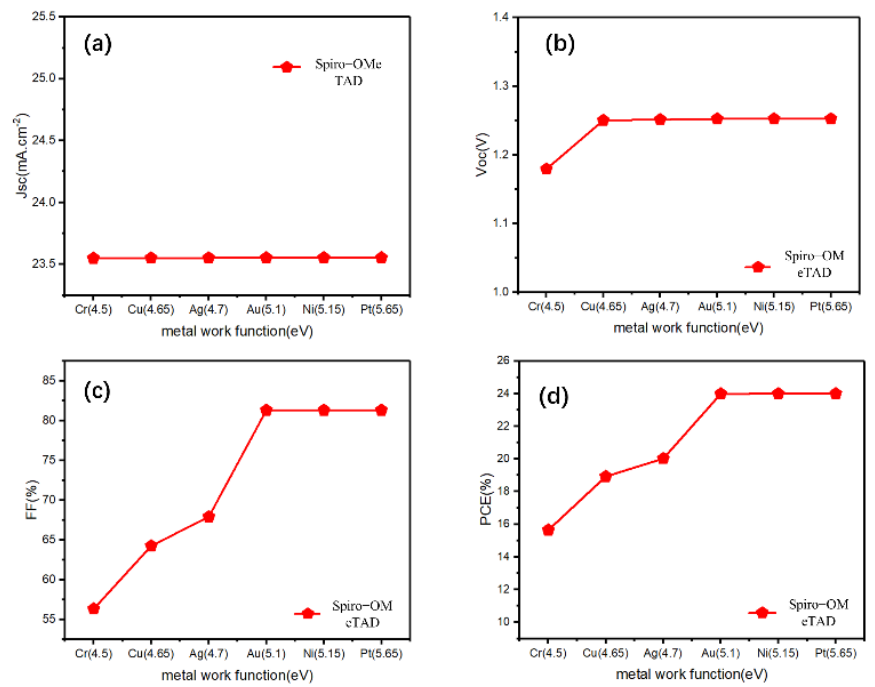
Figure 2. ( a – d ) The photovoltaic parameters ( J sc , V oc , FF , PCE ) for the reference n-i-p devices with Spiro-OMeTAD-HTL and different electrodes .